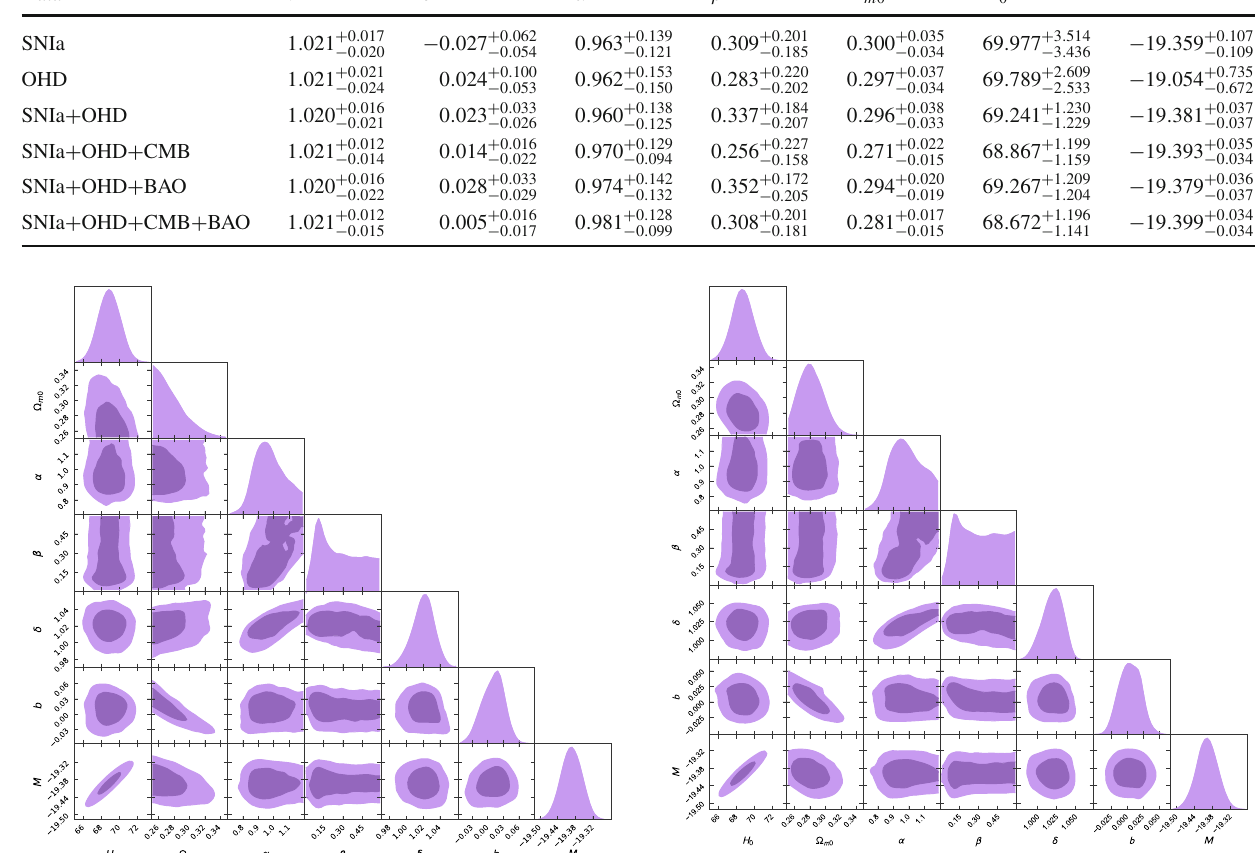
Table 1 The best estimated values and 68.3% confidence limit for interacting THDE model parameters Data